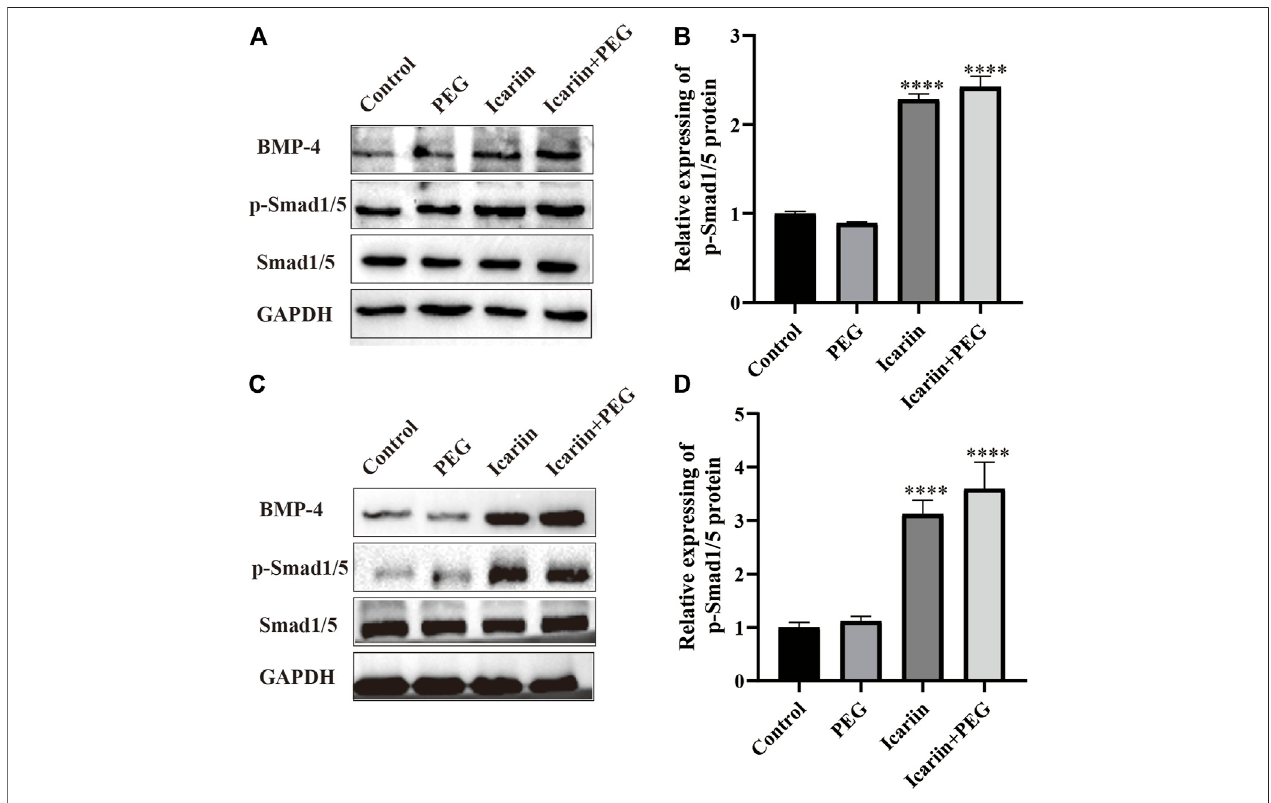
FIGURE 8 | Participation of BMP4 in M2 macrophage polarization and hair-follicle regeneration. (A) Protein expression levels of BMP4, p-Smad1/5, and Smad1/5 as detected by western blotting in the macrophages treated with the different dressings for 48 h. (B) Quanti fi cation of western blotting bands. (C) Protein expression levels of BMP4, p-Smad1/5, and Smad1/5 as detected by western blotting in the HHDPCs treated with the different dressings for 48 h. (D) Quanti fi cation of western blotting